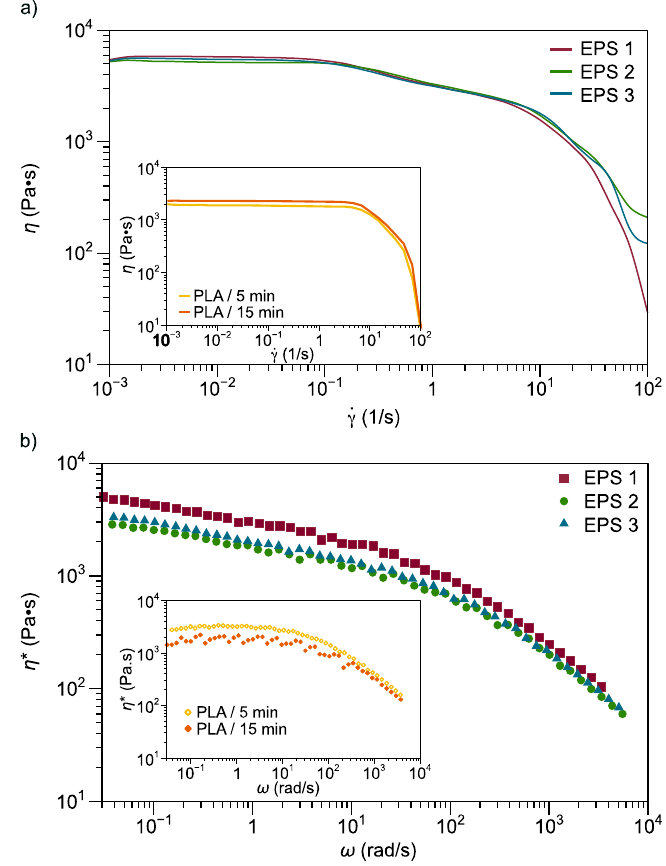
Figure 5. ( a ) Shear viscosity of neat PLA and ternary blends (EPS 1, EPS 2, and EPS 3). ( b ) Complex viscosity of neat PLA and ternary blends (EPS 1, EPS 2, and EPS 3). Additionally, EPS 1, EPS 2, and EPS 3 ternary blends have higher η* than the PLA samples. Particularly in the frequency range of 0.06 rad/s to 0.6 rad/s, this can be attributed to the yield stress resulting from polymer-polymer-polymer interactions [40]. The neat PLA sample (5 min) presents a diminish η* at low frequencies; however, at the frequency of 19.9 rad/s, the viscosity of this sample is similar to that recorded by the ternary mix- tures. Subsequently, at a higher frequency, the values of η* of the neat PLA sample (5 min) are slightly higher, presenting similar shear thinning behavior as the ternary mixtures all profile towards a terminal region.